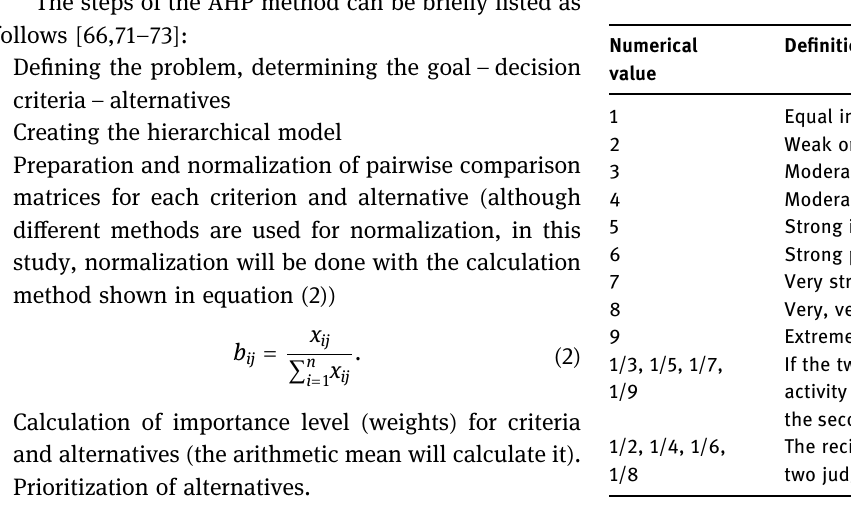
Table 3: The scale of